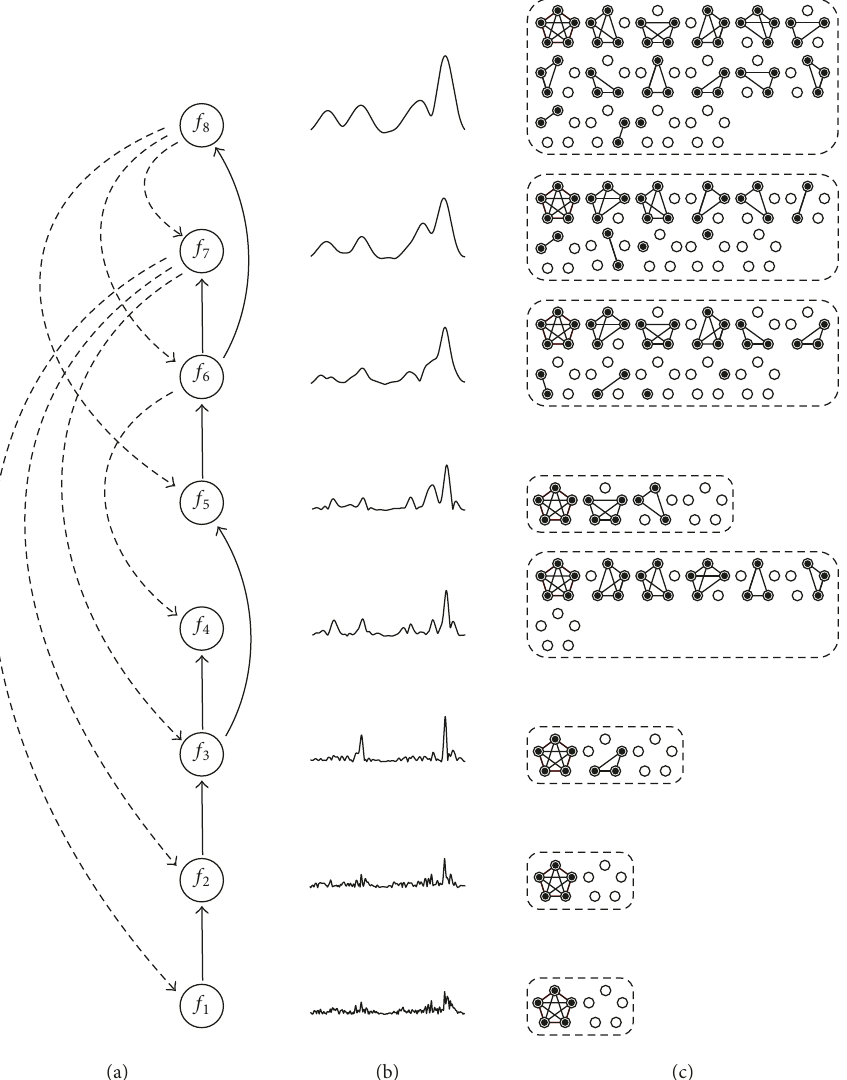
Figure 5: Cross-scale interactions in social coordination. Schematic displaying the results presented in previous figures. (a) Interactions in terms of average transfer entropy between energy levels at different frequencies described by 𝐹 up (𝑓 𝑙 ,𝑑) and 𝐹 down (𝑓 𝑙 ,𝑑) . For simplicity, only the largest upward (solid lines) and downward (dashed lines) values of transfer entropy are represented. (b) Fragment of activity of all nodes in the network (tweets per second) filtered by the 8 wavelets used in the filtering. (c) Metastable states of the models at each frequency. For simplicity, only metastable configurations of the five cities with largest volume of activity are